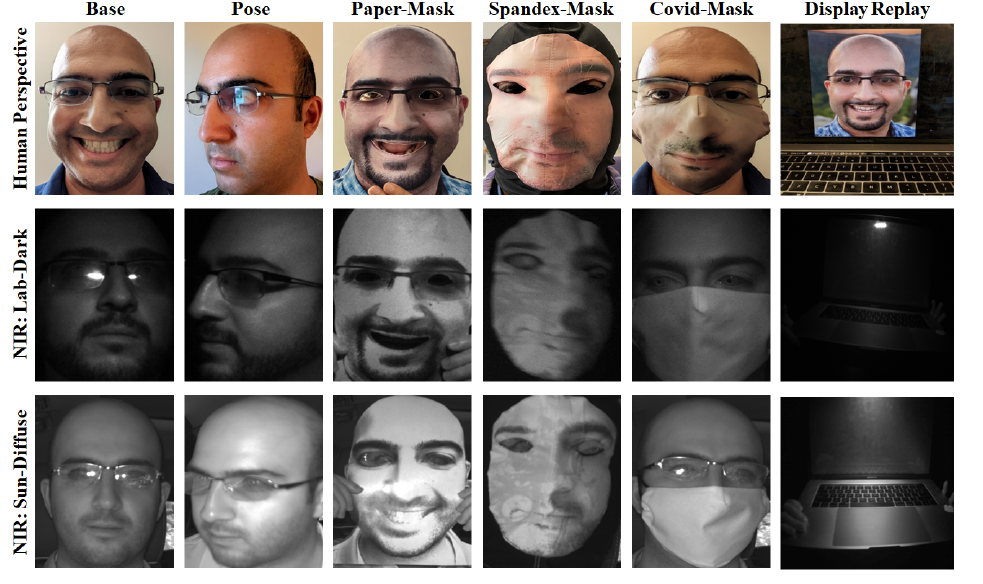
Figure 4. Data collection visualization. This matrix juxtaposes the different types of perspectives captured, noise and spoof attacks (noting that all spoofs also are present with varied pose and distance). This perspective helps visualize the benefits of using illuminated near-infrared versus RGB. Spoofs can be made to easily match the human-perspective, but look like a low-pass filter is applied under the illuminated